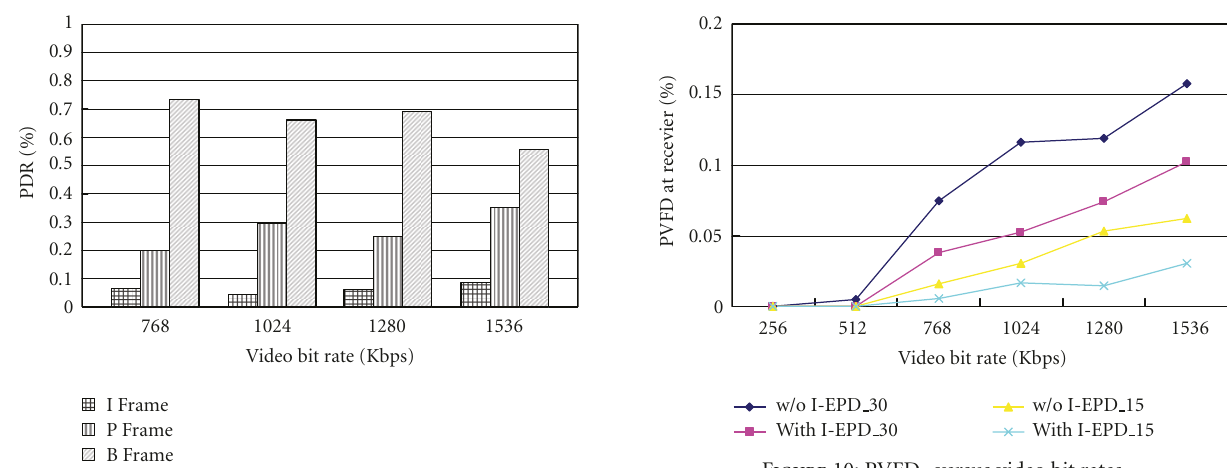
Figure 8: Packet drop ratio at IN B (with I-EPD).